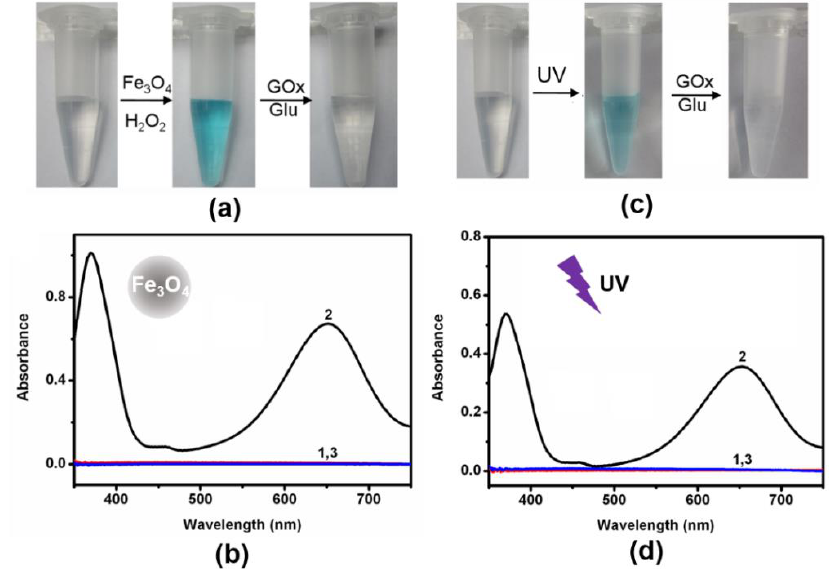
Figure 3. ( a ) Typical photographs of TMB reaction solutions oxidized by Fe 3 O 4 /H 2 O 2 and oxTMB reaction solutions reduced by GOx/glucose. ( b ) UV-vis absorption spectra of TMB reaction solutions in the presence of (1) no reactants; (2) Fe 3 O 4 NPs and H 2 O 2 ; (3) Fe 3 O 4 NPs, H 2 O 2 , glucose, and GOx. ( c ) Typical photographs of TMB reaction solutions treated by UV-light and oxTMB reaction solutions reduced by GOx/glucose. ( d ) UV-vis absorption spectra of TMB reaction solutions in the presence of (1) no reactants; (2) UV-light; and (3) UV-light, glucose, and GOx. ([TMB] = 200 μM, [Fe 3 O 4 NPs] = 20 μg/mL, [H 2 O 2 ] = 10 mM, [glucose] = 5 mM, [GOx] = 1 unit/mL, [citrate buffer] = 40 mM, pH 6.0).